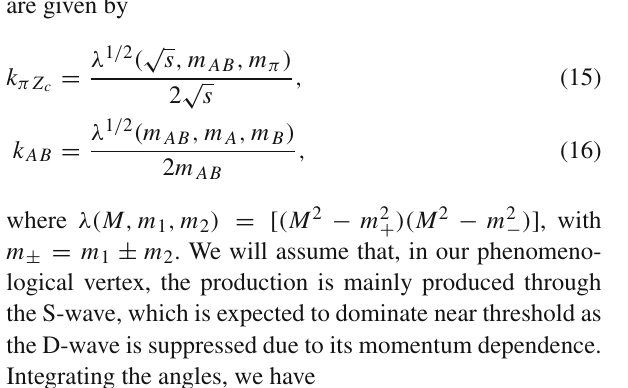
√ s . The on-shell momenta